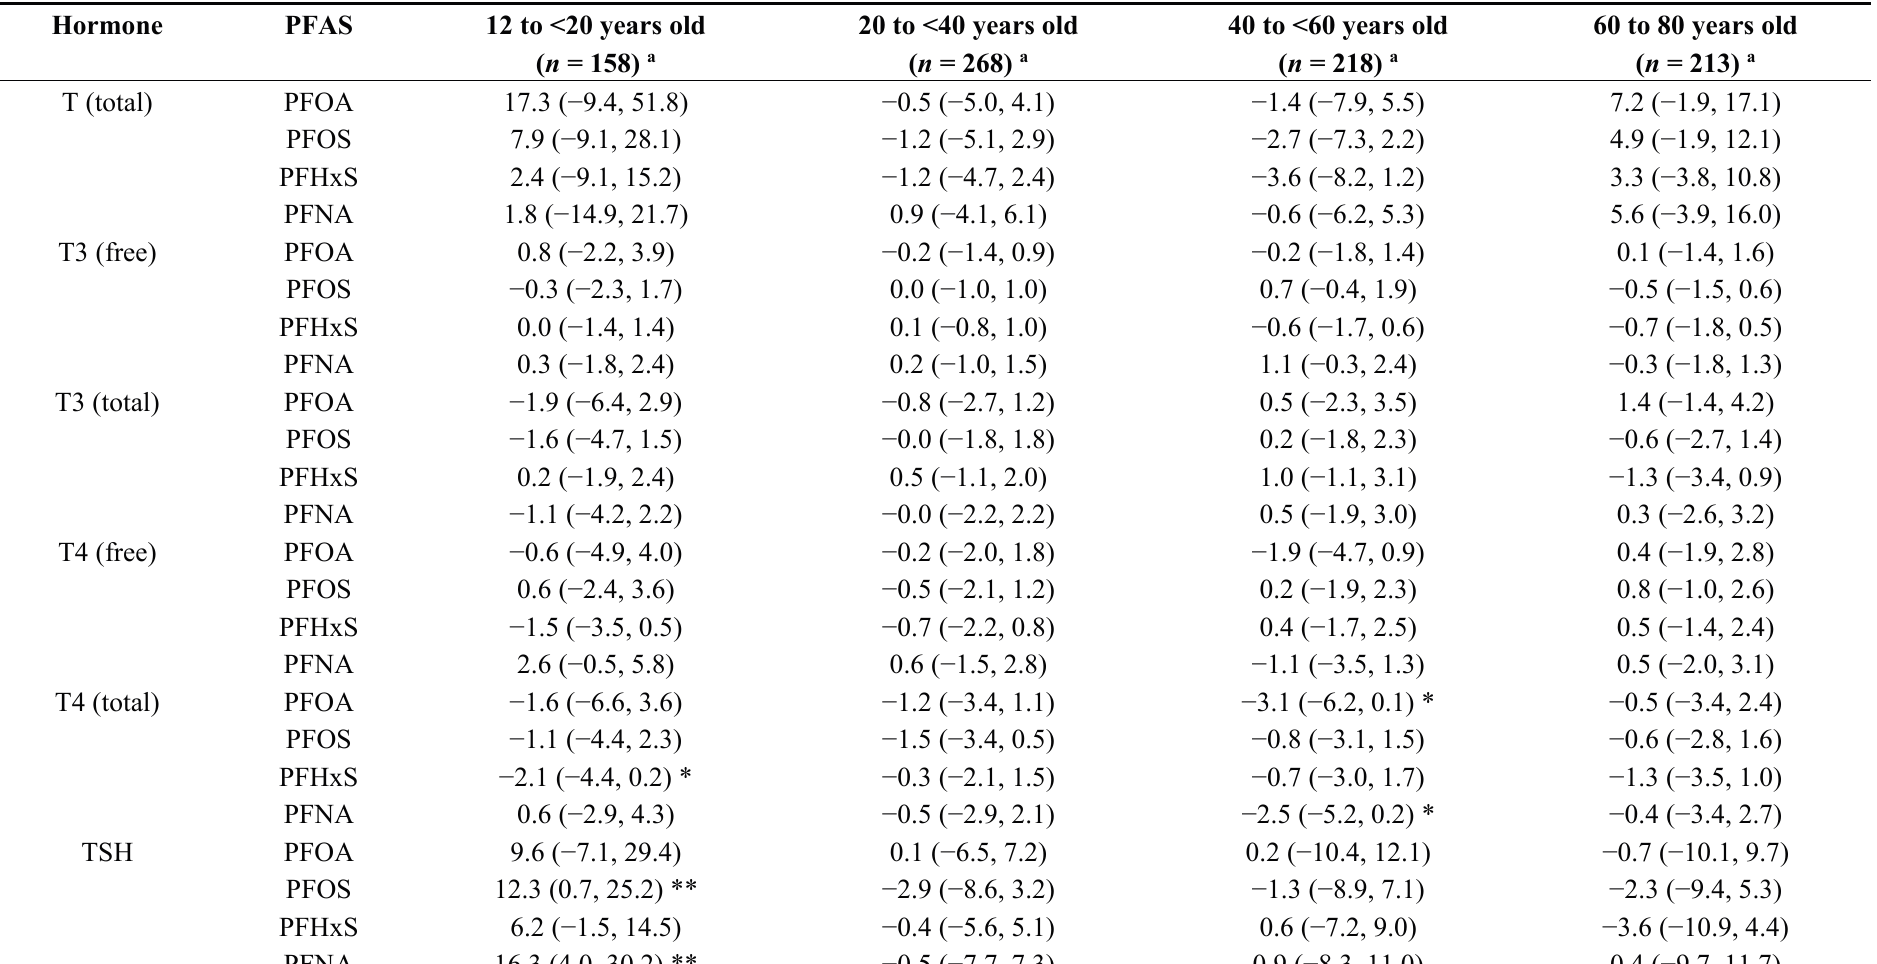
Table 4. Percent change (95% CI) in serum hormone concentration associated with a doubling (100% increase) in serum PFAS concentration among males from NHANES 2011–2012 (adjusted